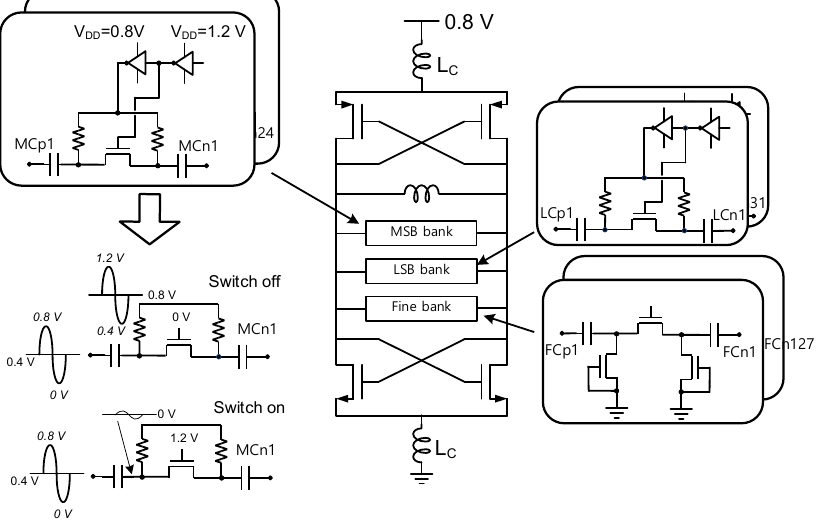
Figure 4. Structure and operation principle of the switch and control circuit for tuning the capacitor in a capacitor bank.